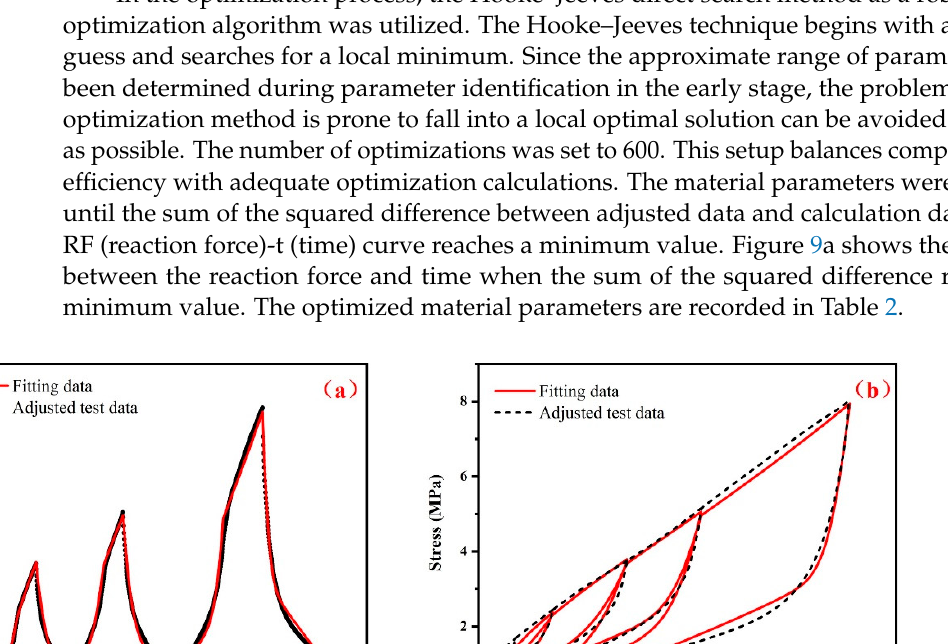
Figure 8. The boundary conditions for the unit cell model in the optimization process.